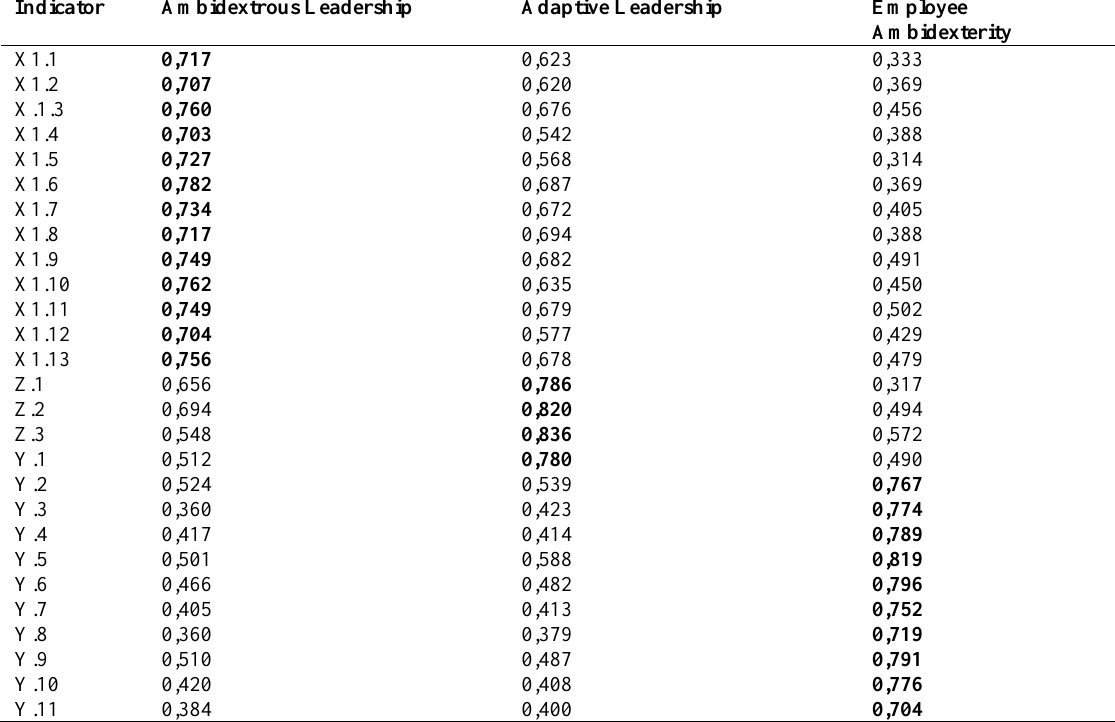
Table 3: Discriminant Validity